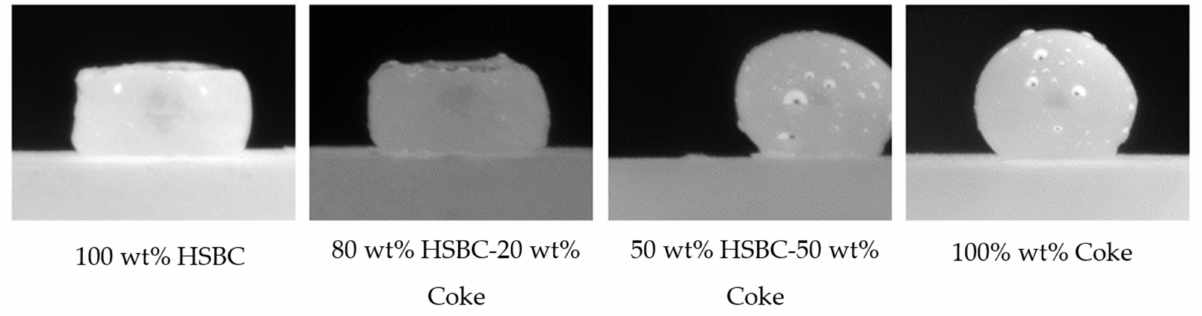
Figure 12. Enhancement of substrate interaction with slag by blending with coke.